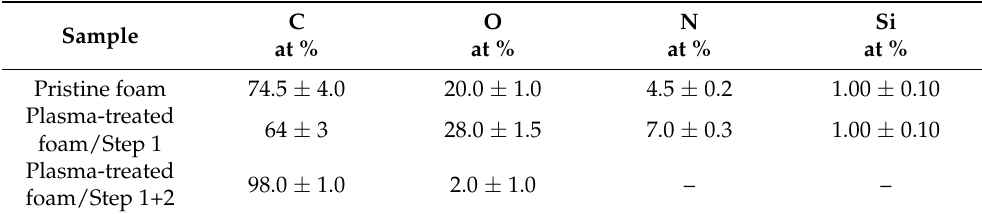
Table 1. XPS surface atomic concentrations of the pristine PU foam, the PU foam after step 1, and the PU foam after the two-step plasma process. Step 1—etching/nanotexturing: He/0.5% O 2 fed DBD, 20 kHz, 1.3 kV rms , 10 min; step 2—thin-film deposition: He/0.5% C 2 H 4 fed DBD, 20 kHz, 1.3 kV rms , 10 min.